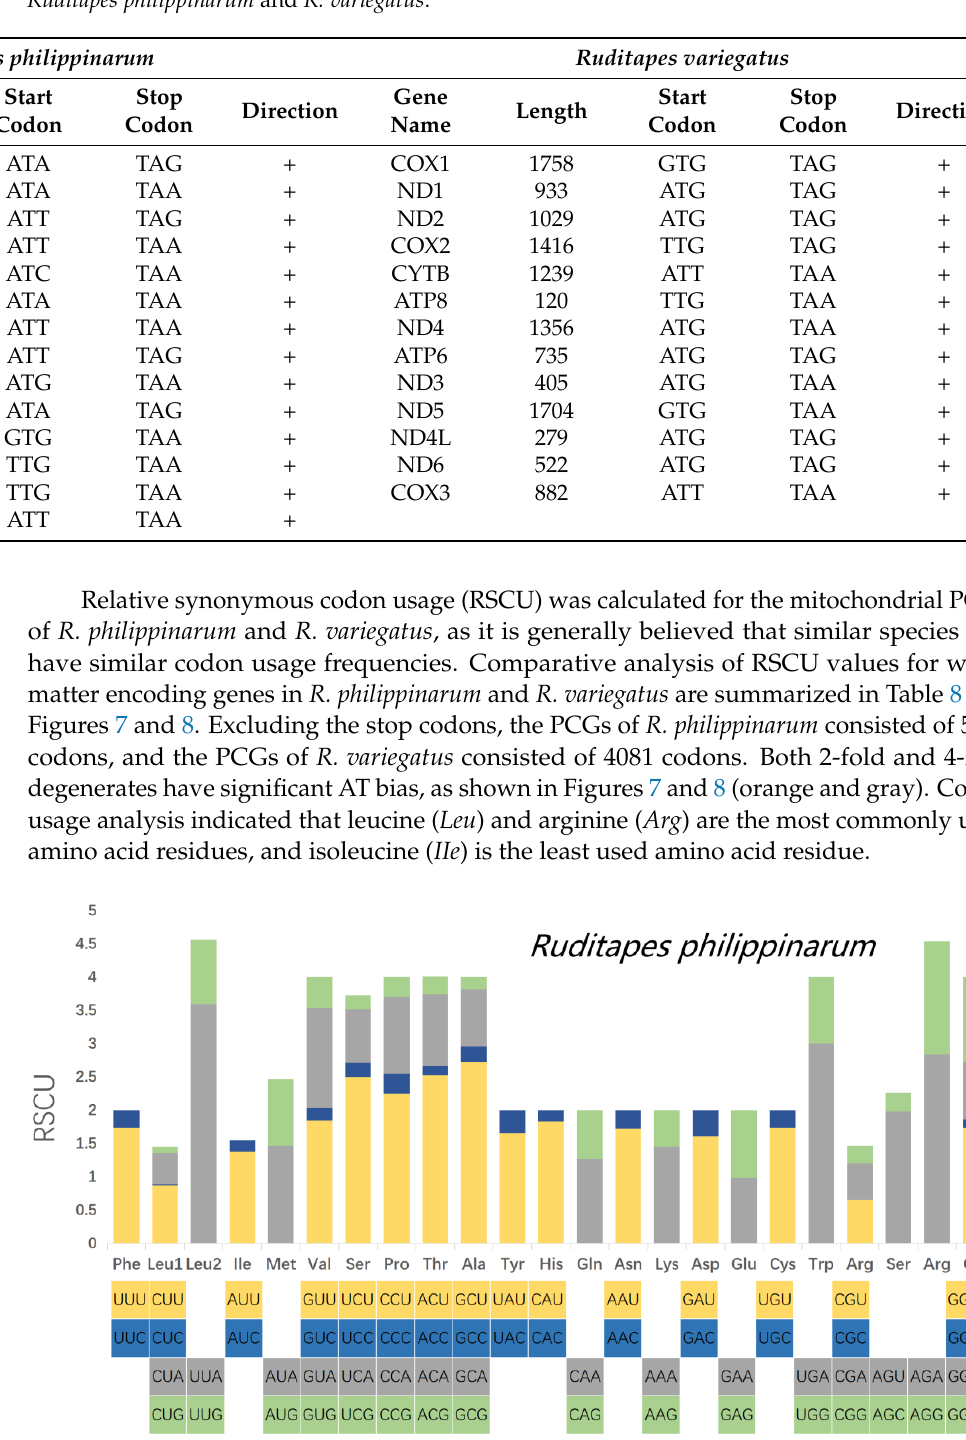
Figure 7. Relative synonymous codon usage (RSCU) in the mitochondrial genome of Ruditapes philippinarum.